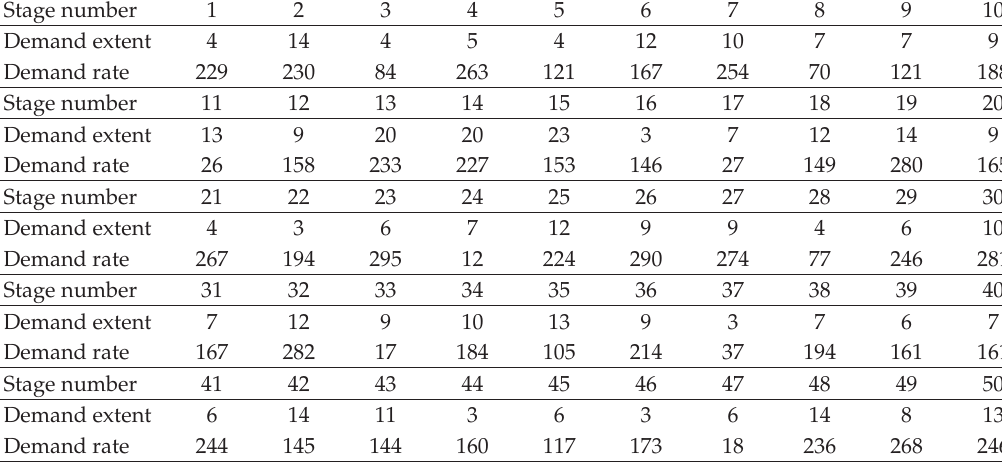
Table 3: Demand data in Problem